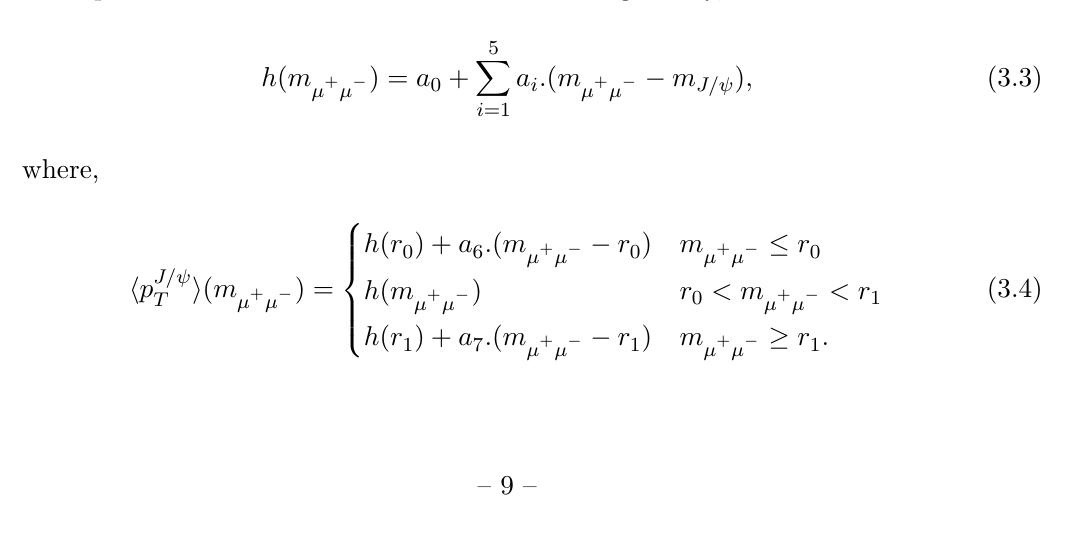
Figure 2 . Example of h p J/ψ i extraction in highest, intermediate and lowest N corr T √ collisions at s = 5.02 and 13 TeV. The scattered points represent the experimental data while various lines show the signal and background